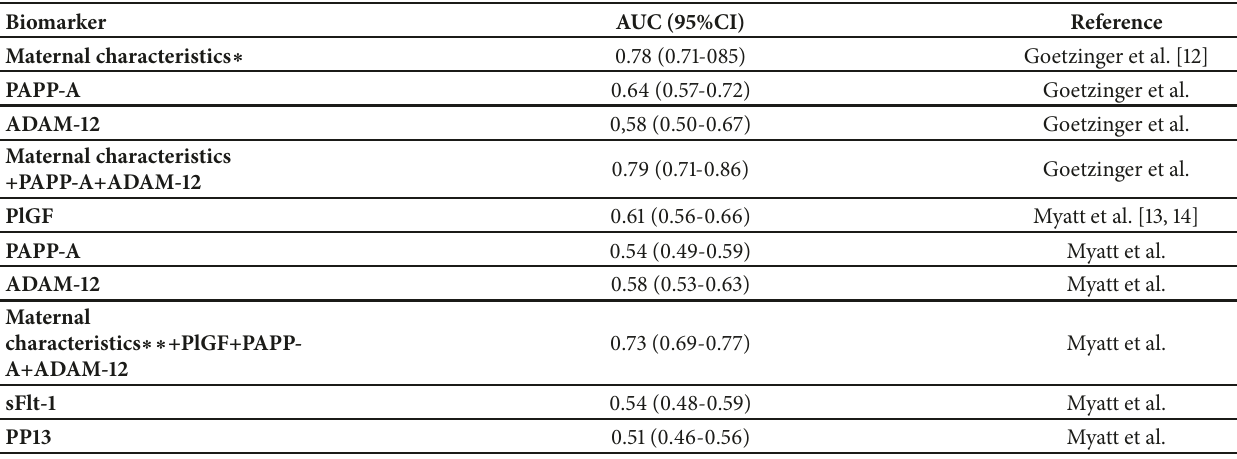
Table 1: Preeclampsia prediction potential of biomarkers and maternal